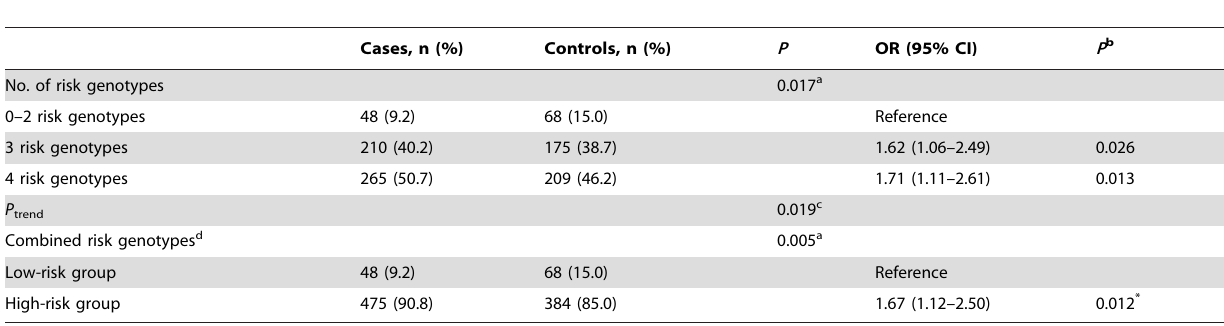
Figure 1. Haplotypes of AKT1 polymorphisms and the risk of nasopharyngeal carcinoma. ( a ) Genomic structure of the AKT1 locus and the polymorphic sites used. Exons (boxes) and introns are not drawn to scale; open boxes represent noncoding sequences, and filled boxes represent coding sequences. The physical distance between SNPs is shown in nucleotides. ( b ) Linkage disequilibrium (LD) map of SNPs based on D . ( c ) LD map of SNPs based on r 2 . ( d ) Global P values from single-locus and multi-locus (two to five) based association analysis. ( e ) Haplotypes showing significant genetic associations with the risk of nasopharyngeal carcinoma. The two-SNP core haplotype is highlighted in gray. doi:10.1371/journal.pone.0092135.g001 Table 3. Combined effects of the genetic variants in the PTEN , AKT1 , MDM2 and p53 genes on the risk of nasopharyngeal